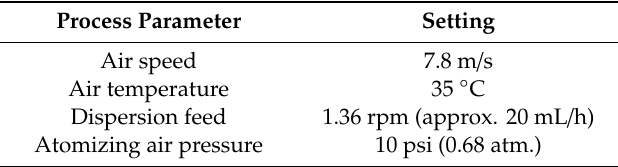
Table 4. The process parameters used in the manufacturing of the meloxicam pellets coated with Acryl-EZE ®